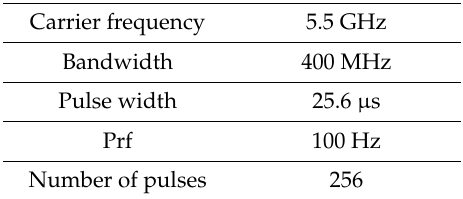
Table 6. Radar parameters of Yake-42 real-data.